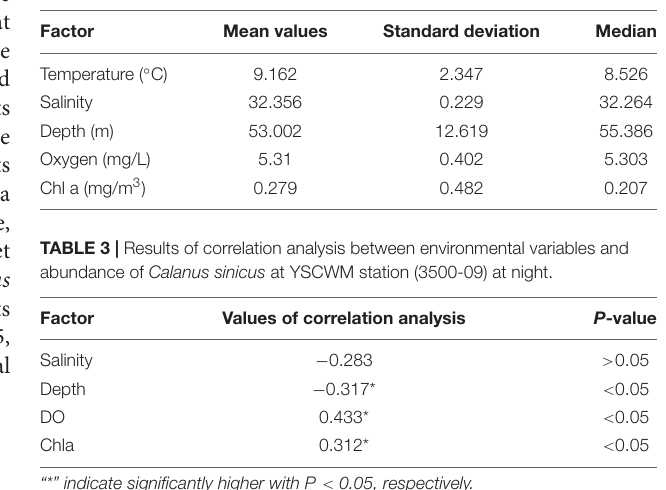
TABLE 2 | Average values of environmental factors at 18 stations by VPR and CTD.